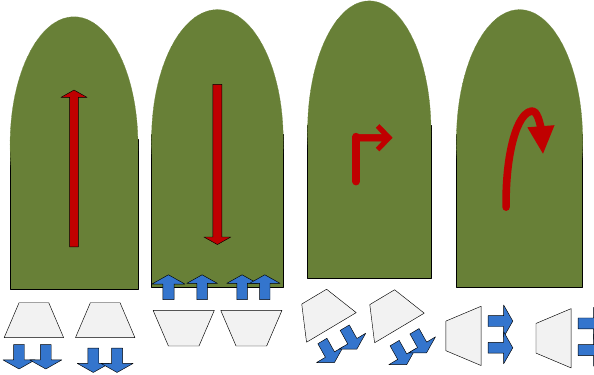
Figure 3. Schematic diagram of full rotation tugboat operation.